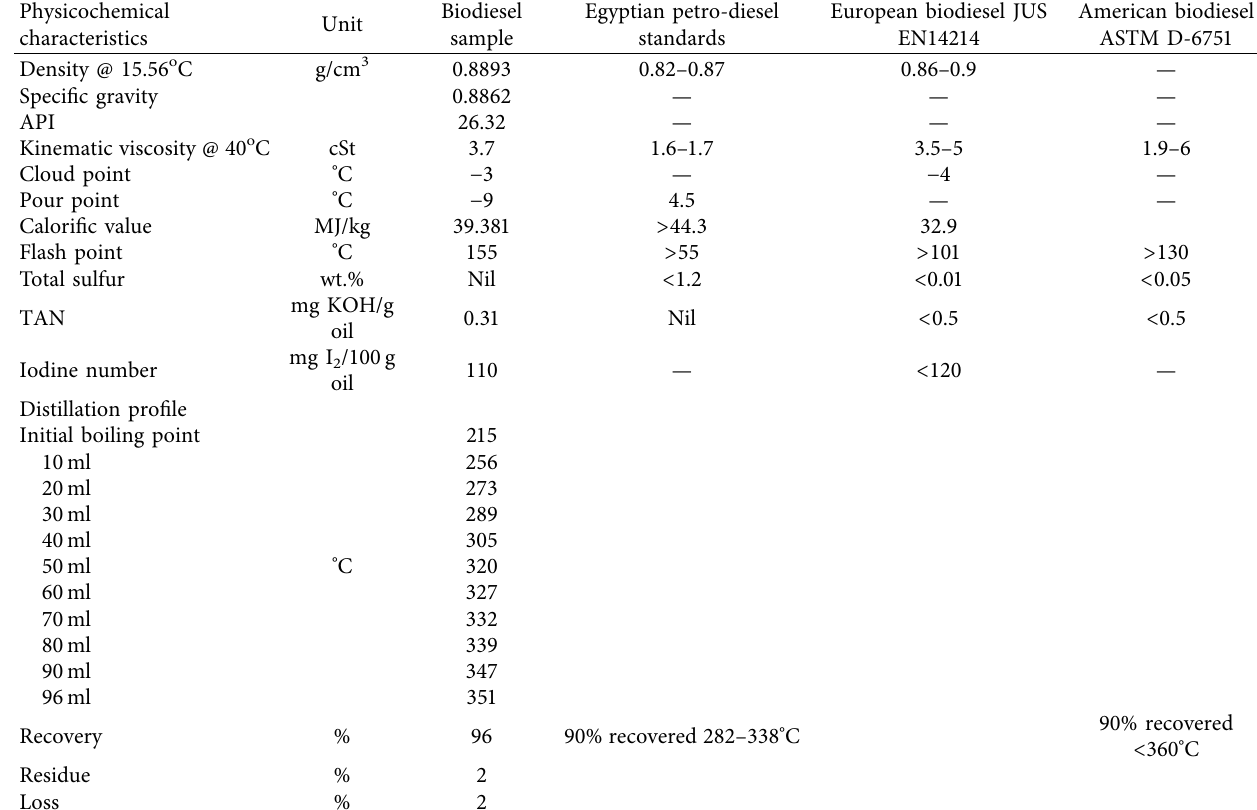
Table 5: Te physicochemical characteristics of the produced biodiesel compared to the international biodiesel standards and Egyptian petro-diesel standard specifcations. Physicochemical